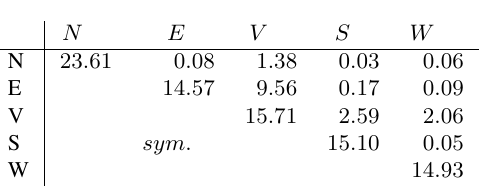
Table 1: Efficiency of SIFT vs. ASIFT features.